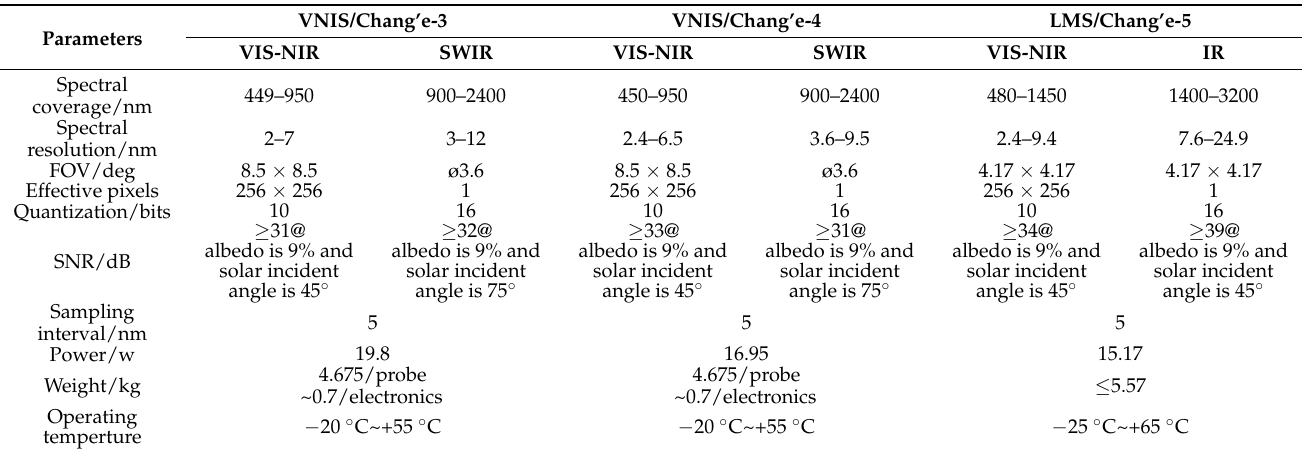
Table 1. Main performance parameters of VNIS and